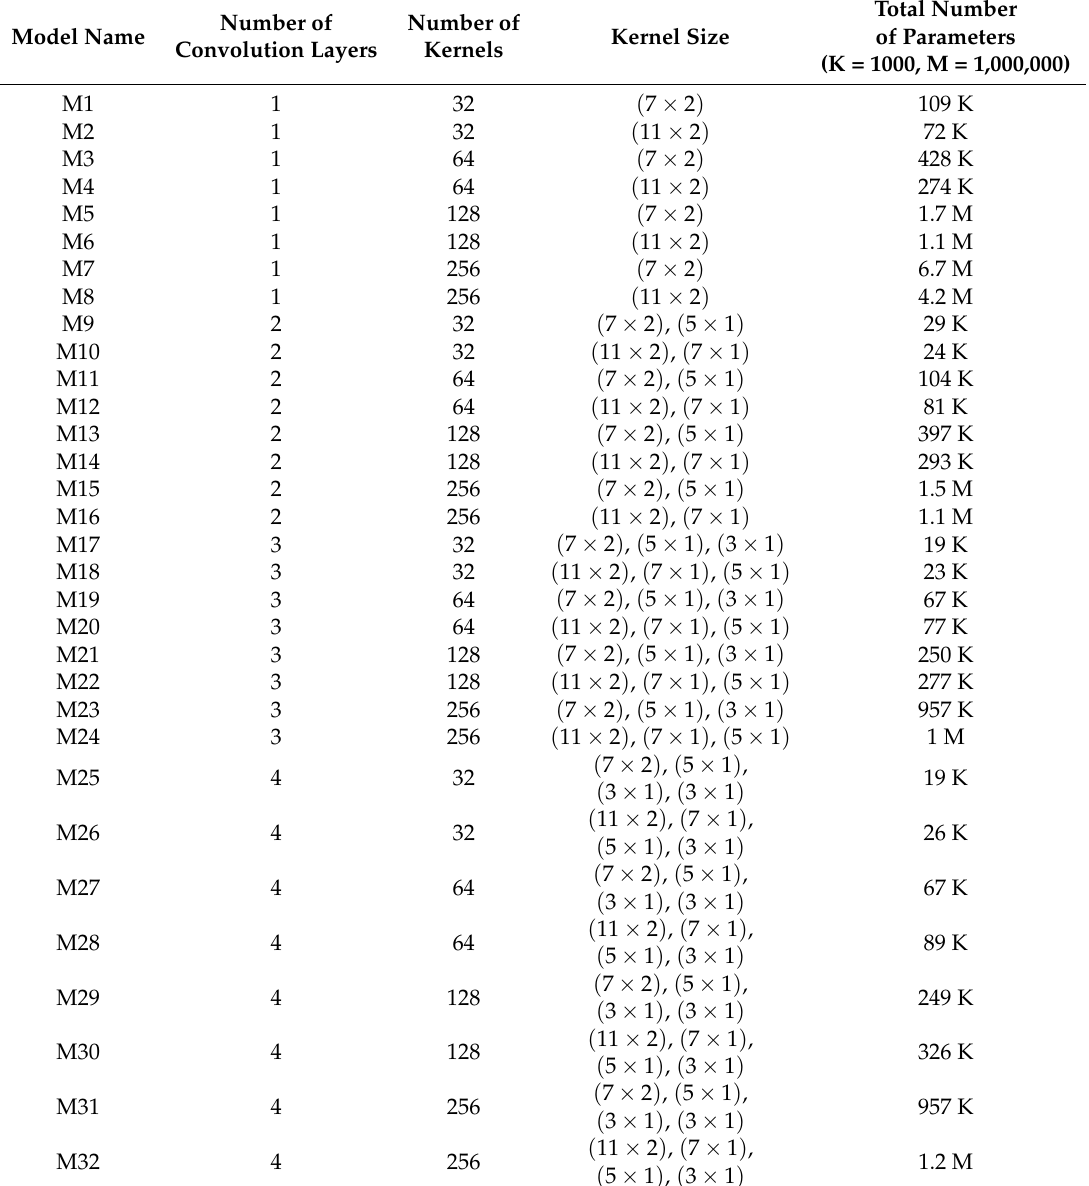
Table 2. Hyperparameters of the examined networks